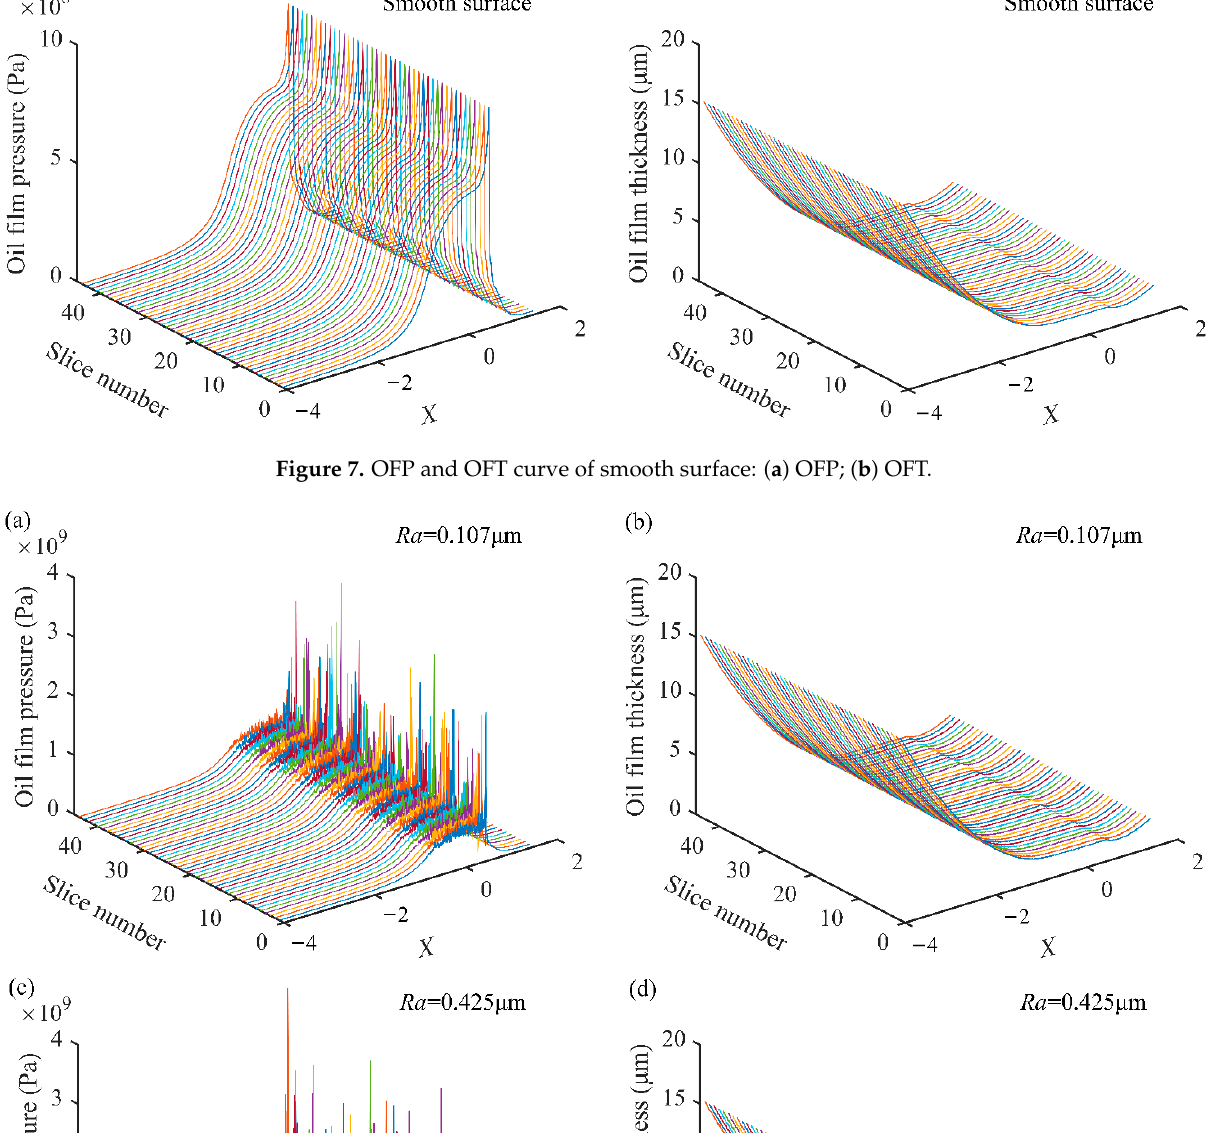
Figure 7. OFP and OFT curve of smooth surface: ( a ) OFP; ( b ) OFT.